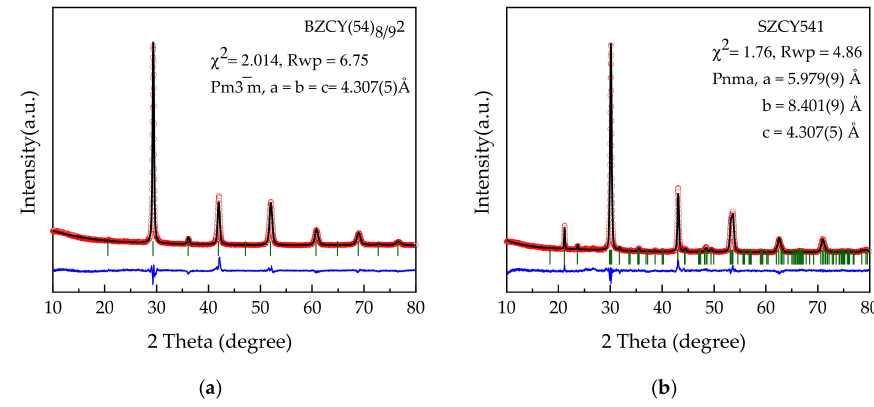
Figure 1. Rietveld refined XRD pattern of ( a ) BZCY(54) 8 / 9 2 powder and ( b ) SZCY541 powder after calcination at 1300 ◦ C: observed X-ray di ff raction intensity (black points) and calculated curve (red line). The bottom curve is the di ff erence of the patterns, Yobs − Ycal, and the small greenish bars indicate the angular positions of the allowed Bragg reflections. Table 1. Physical properties of the ceramic powders used for tape casting and processing.